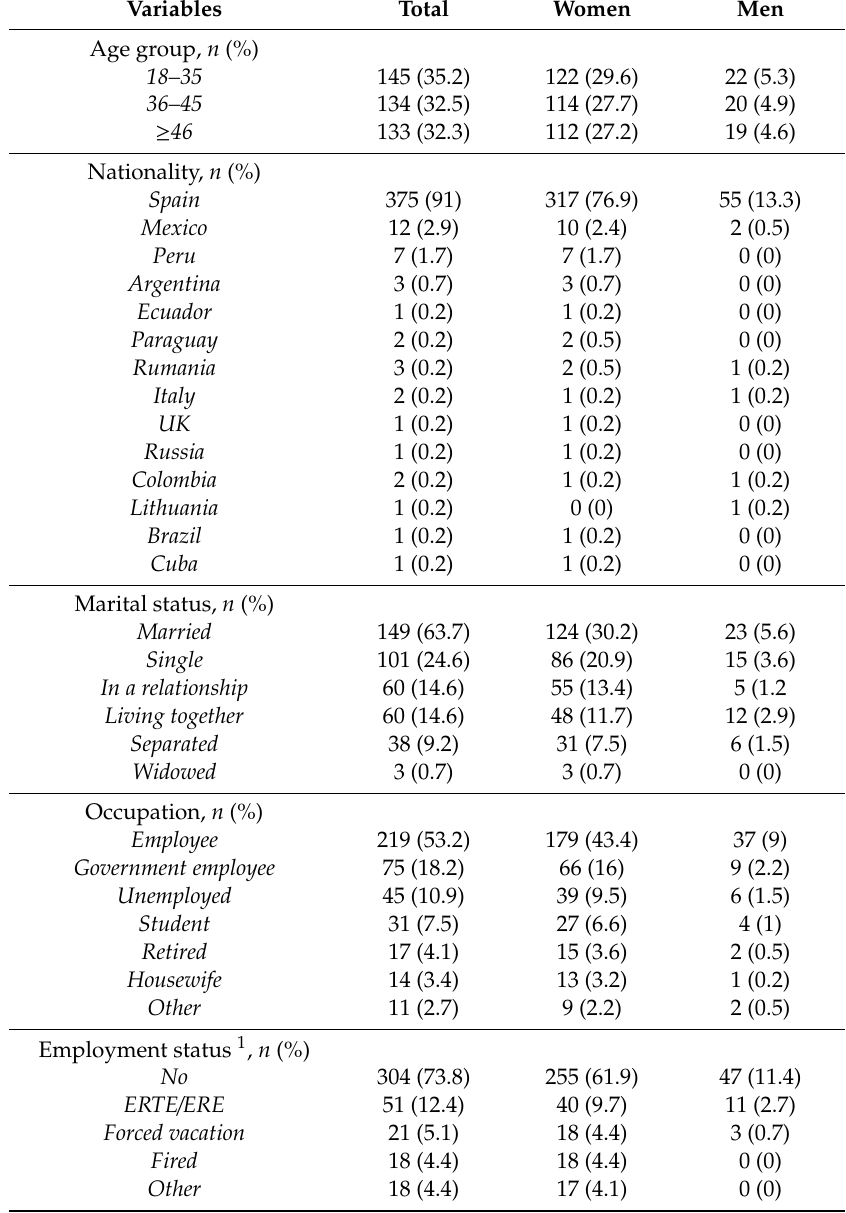
Table 1. Participant